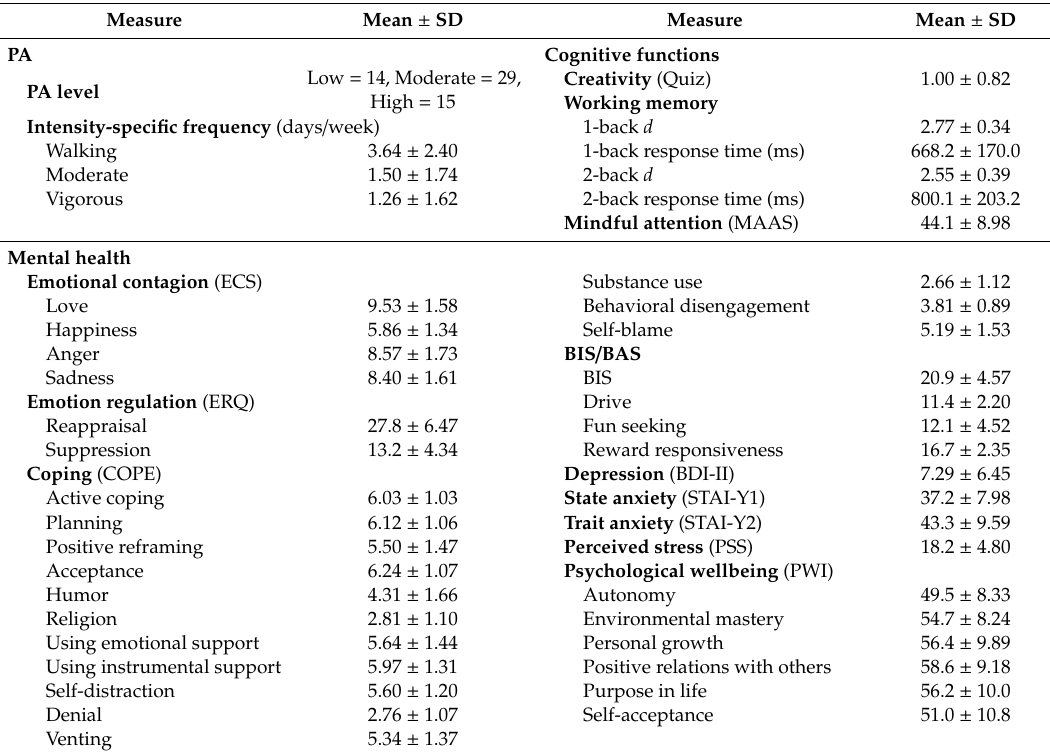
Table 1. The score of each measure in this study. n = 49 for creativity and n = 58 for all other measures. Measure Mean ± SD Measure Mean ± SD PA Cognitive functions PA